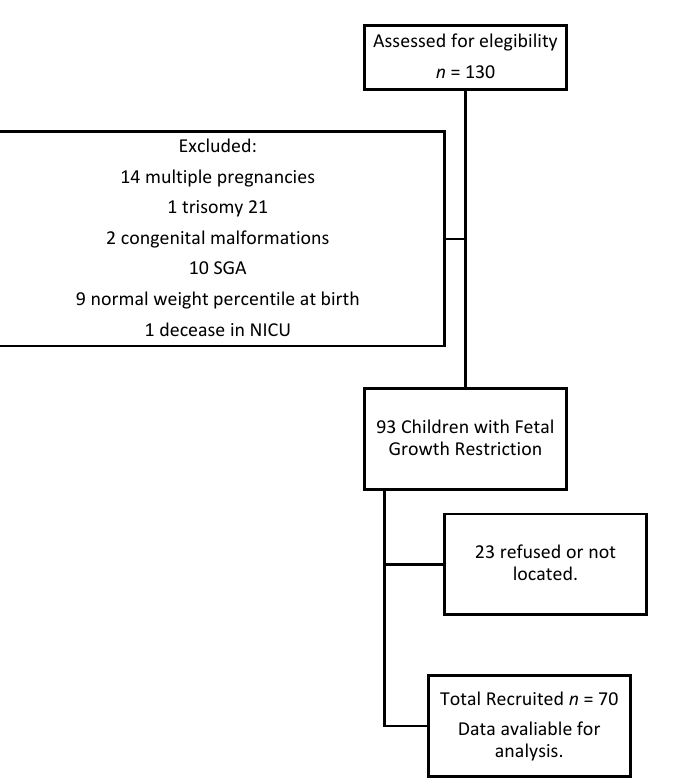
Figure 1. Flow-diagram: Participants in the study.